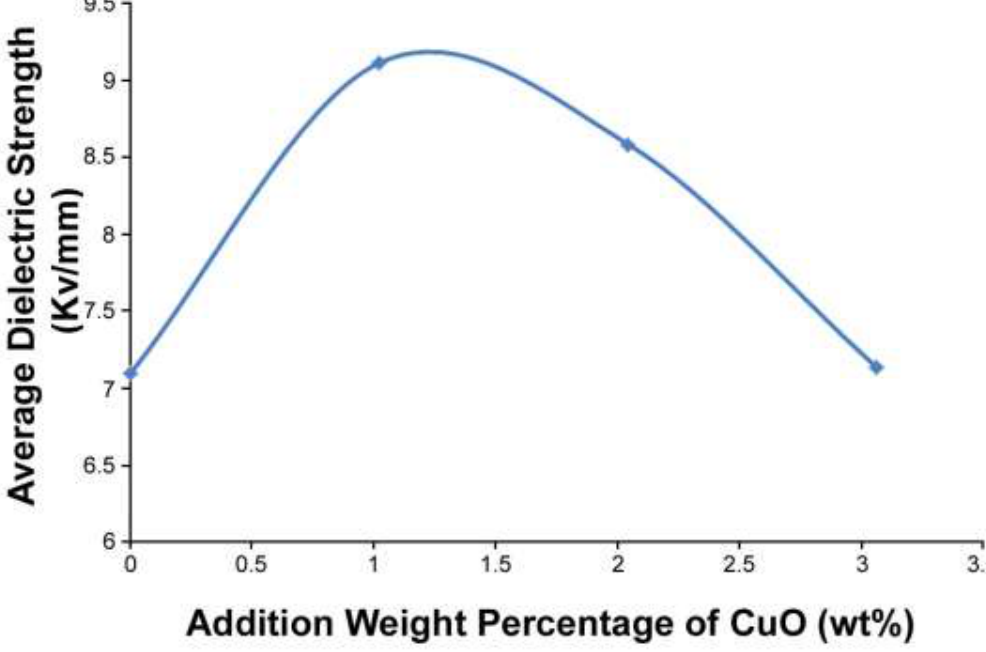
Figure 6: The relationship between average dielectric strength and addition weight percentage of CuO. Upon the addition weight percentage of CuO within glass batch ingredients is increasing, the value of Weibull modulus is increasing until 2 wt% CuO and starting to decrease as shown in figure (7). The dissolved CuO within the glass batch helps the glass structure be more homogeneous by occupied octahedral sites in the glass network with Cu 2+ ions while Li + ions are the most occupied interstitial sites. During the heat treatment, the movement of the ions be more with high content of CuO but facing the high viscosity of the glass ingredients which causing micro-cracks and pores. P O and TiO as nucleating agents help to increase the size and amount of the micro- 2 5 2 cracks, pores despite the high value of the Weibull modulus 9.0792 at 2 wt% CuO that indicated more homogeneity but different and spacing between the values of dielectric strength in figure (3) a. The homogeneity is improved with addition CuO but little amounts and proofs it by Weibull modulus and FESEM and figure (7) represents the basic relation and idea in the